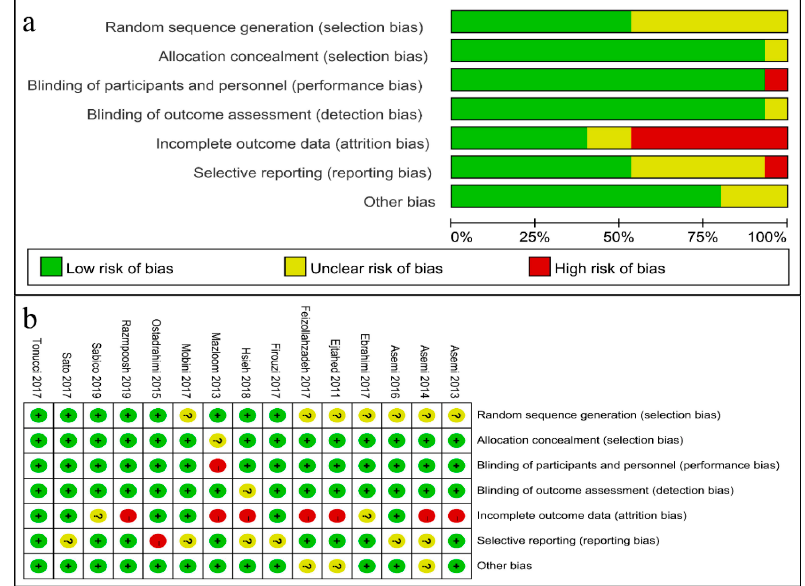
Figure 2. Risk-of-bias assessment for the included RCTs. Risk of bias summary ( a ) and graph ( b ). Note: “+”: low risk, “?”: unclear risk, “ − ”: high